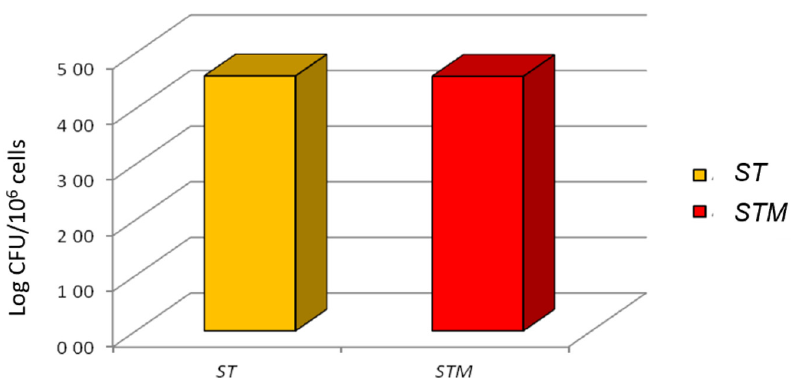
Figure 3. Invasion test: ST and STM ’s ability to invade CF33 cells; the CFUs grown on XLD agar plates are reported on the y-axis.